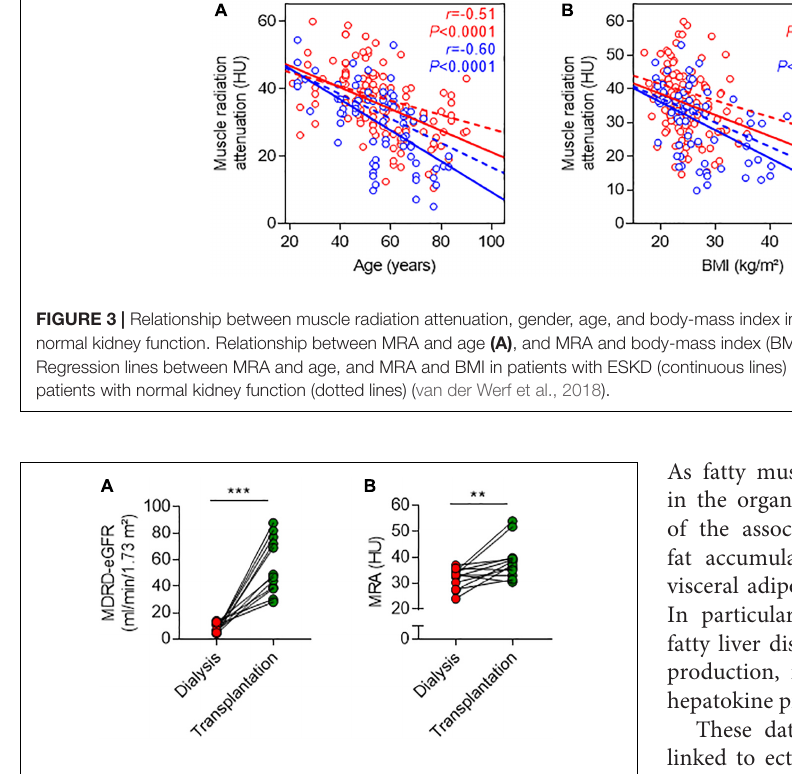
FIGURE 4 | Dynamic changes in muscle radiation attenuation after kidney transplantation. Changes in MDRD-estimated glomerular filtration rate (eGFR) (A) and MRA (B) after kidney transplantation. Mean ( ± SD) MRA increased from 32.0 ( ± 3.9) to 38.8 ( ± 7.3) HU after transplantation (median of differences 5.41, Wilcoxon matched-pairs signed rank test, exact P = 0.009). ** P < 0.01 and *** P <